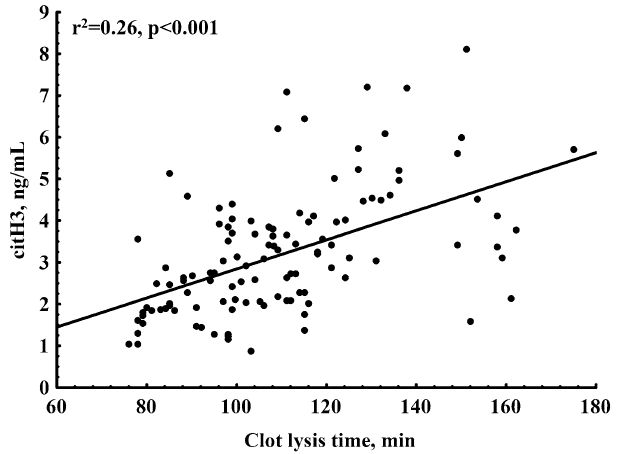
Figure 3. Association of clot lysis time with citrullinated histone H3 (citH3) levels in acute PE